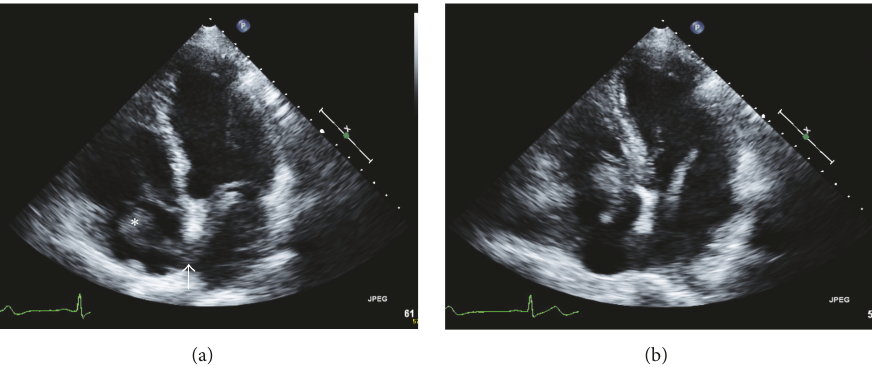
Figure 1: (a) Transthoracic echocardiogram apical four-chamber view in diastole showing a large thrombus (asterisk) extending from the right atrium to the left atrium via a patent foramen ovale (arrow). (b) Apical four-chamber view in diastole demonstrating prolapse of the thrombus across the mitral and tricuspid